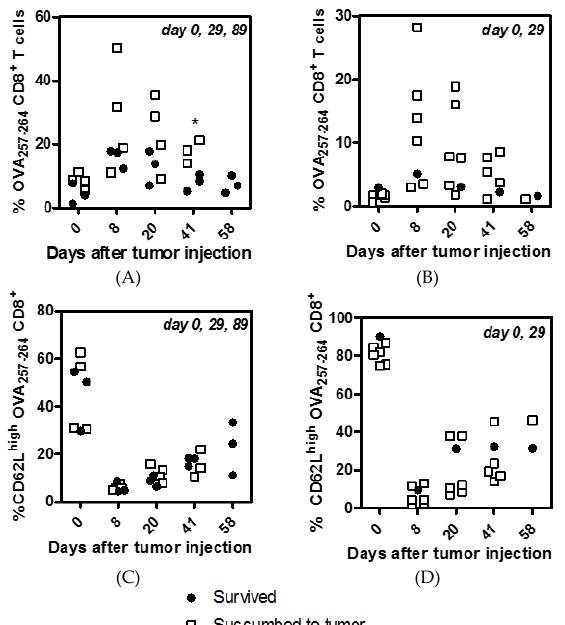
Figure 5. CD8 + T cell frequency and CD62L phenotype following tumor challenge after vaccination. C56BL/6 mice were vaccinated by s.c. injection with MS-OVA in the middle of the dorsal flank at days 0, 29 and 89 (panels A and C ) or 0, 29 (panels B and D ) as indicated at the top of each panel. Two-hundred sixteen days after initial vaccination, 10 6 B16-OVA cells were injected s.c. in the lower dorsal flank. Blood samples were taken after tumor injection and assayed for the frequency of OVA 257–264 specific CD8 + T cells (panels A and C ) and their percent expression of CD62L (panels B and D ). Surviving mice and those that succumbed to tumor mice were segregated for analysis. ( A ) Two-tailed t -test with Welch (cid:48) s correction for unequal variance *, p = 0.02. Data are graphed for individual mice, n = 3–7/time